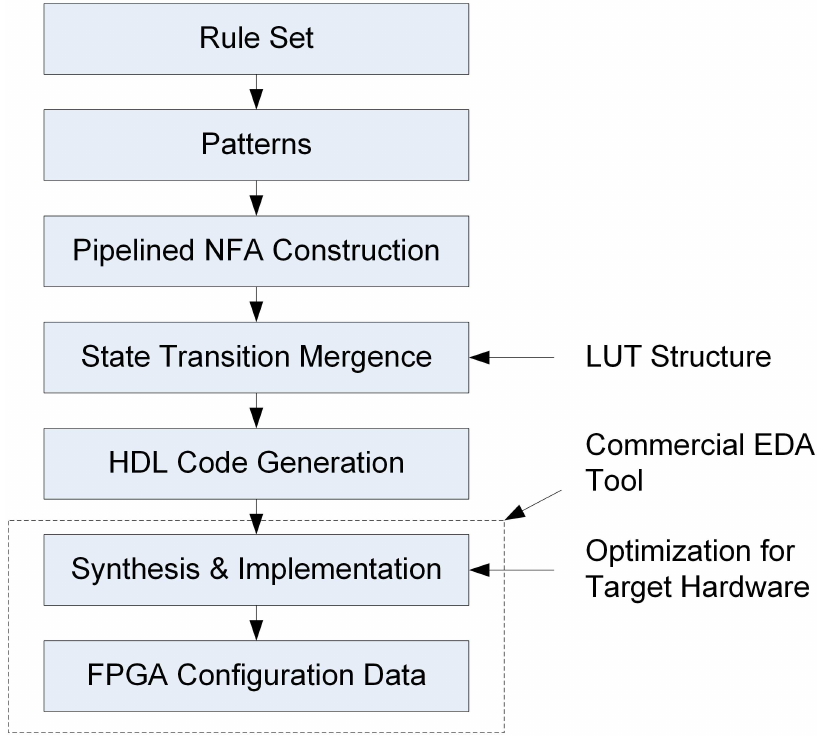
Fig 8. Flow to obtain FPGA configuration data from a rule